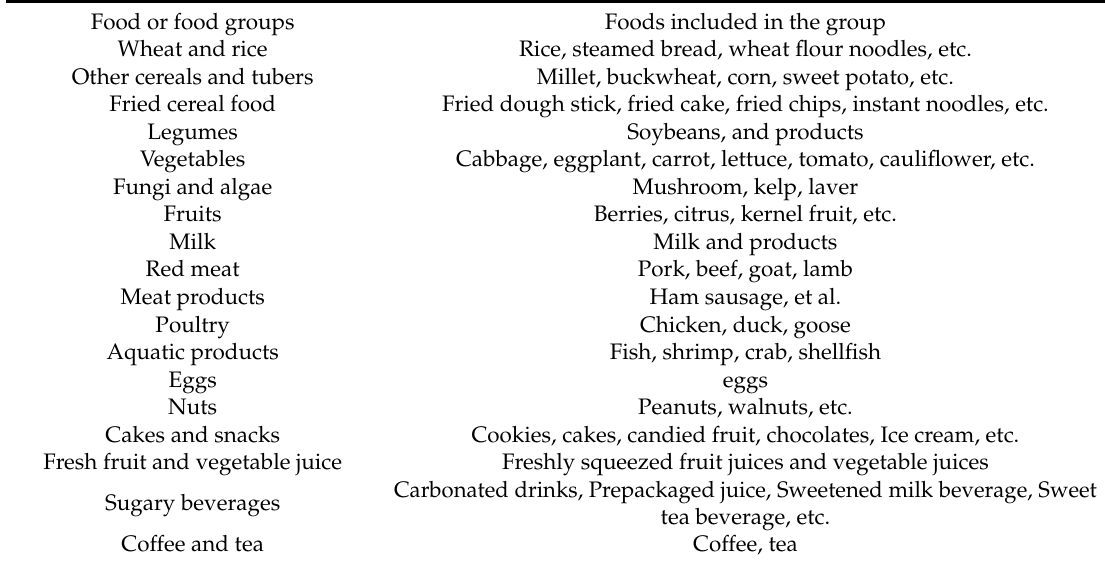
Table A1. Food groups in the factor analysis.